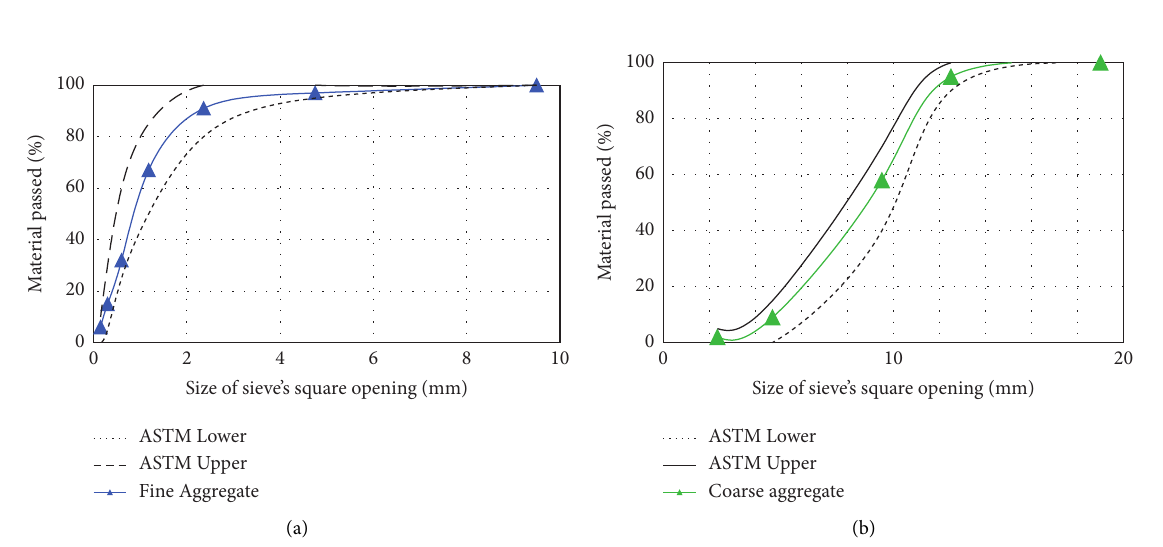
Figure 1: The aggregate size gradation curves of (a) quarry sand and (b) coarse aggregate following ASTM C33 [50].